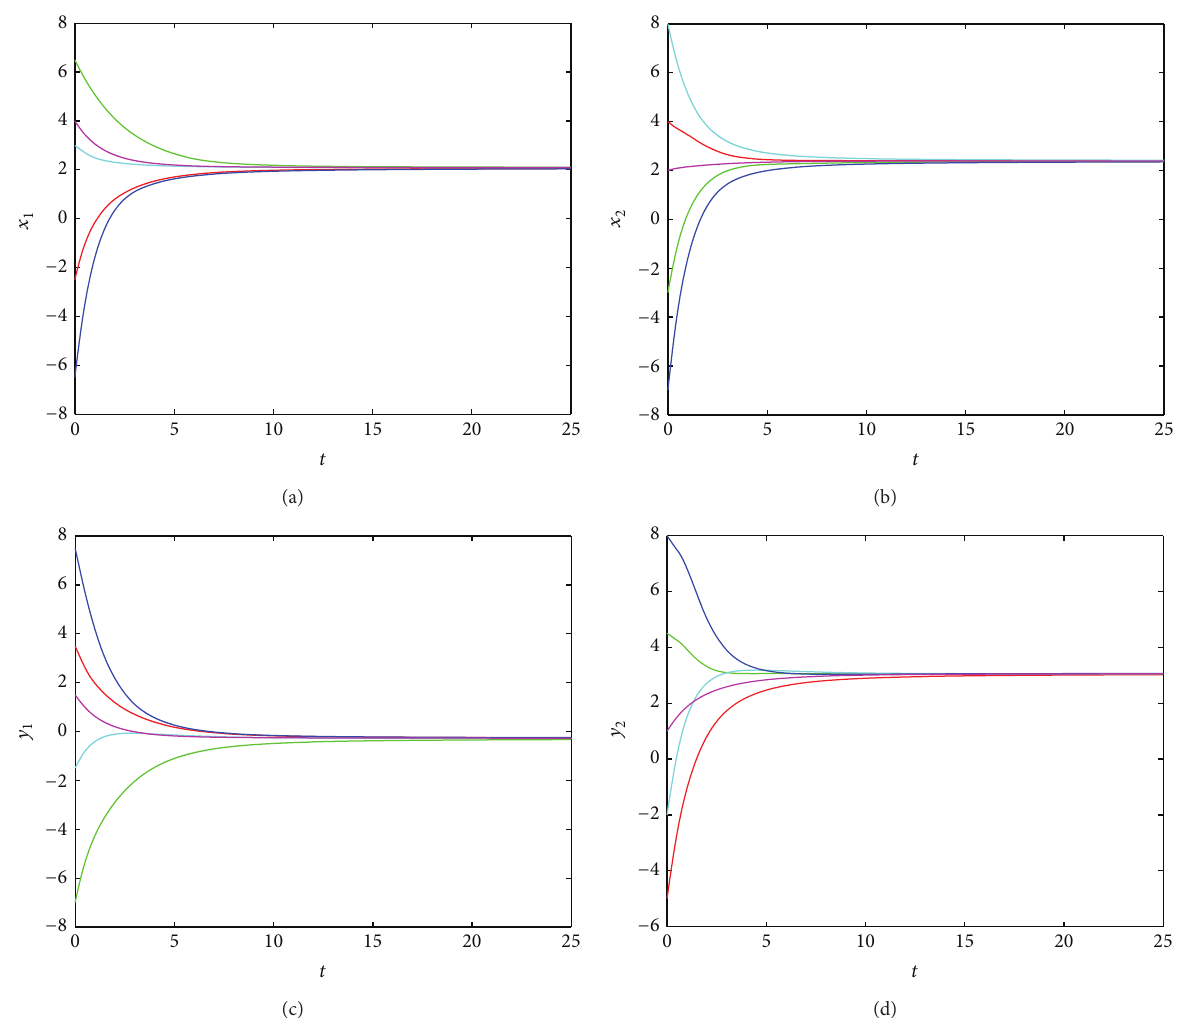
Figure 1: Transient states of the fractional-order BAM neural networks in Example 1 with 𝛼 = 0.95 , 𝜎 = 0.25 , and 𝜏 = 0.50 .